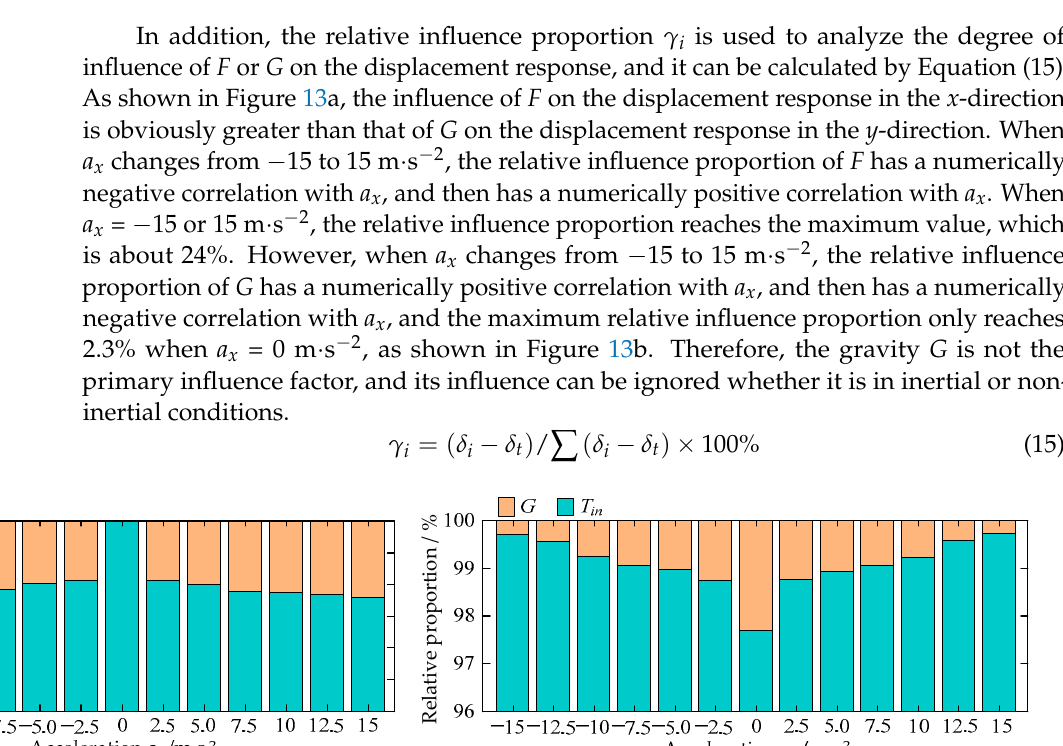
Figure 12. Displacement responses with or without additional inertial forces of node 14 when a x changes from 10 to − 10 m · s − 2 : ( a ) x -direction; ( b ) y -direction.